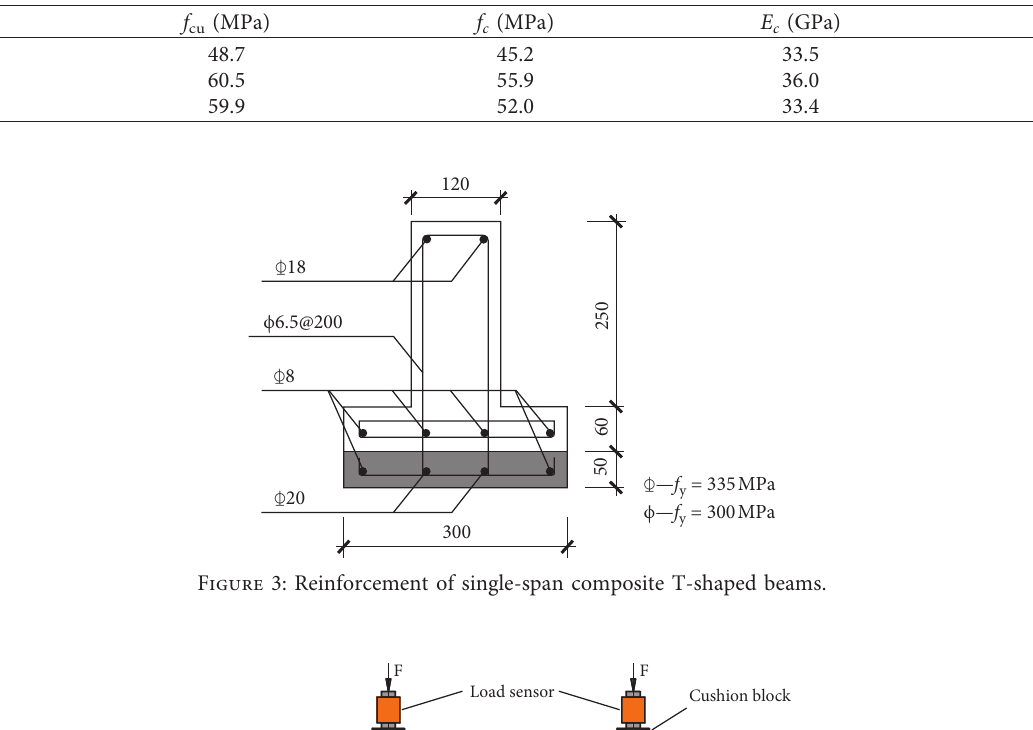
Table 4: Mechanical prosperities of concrete.